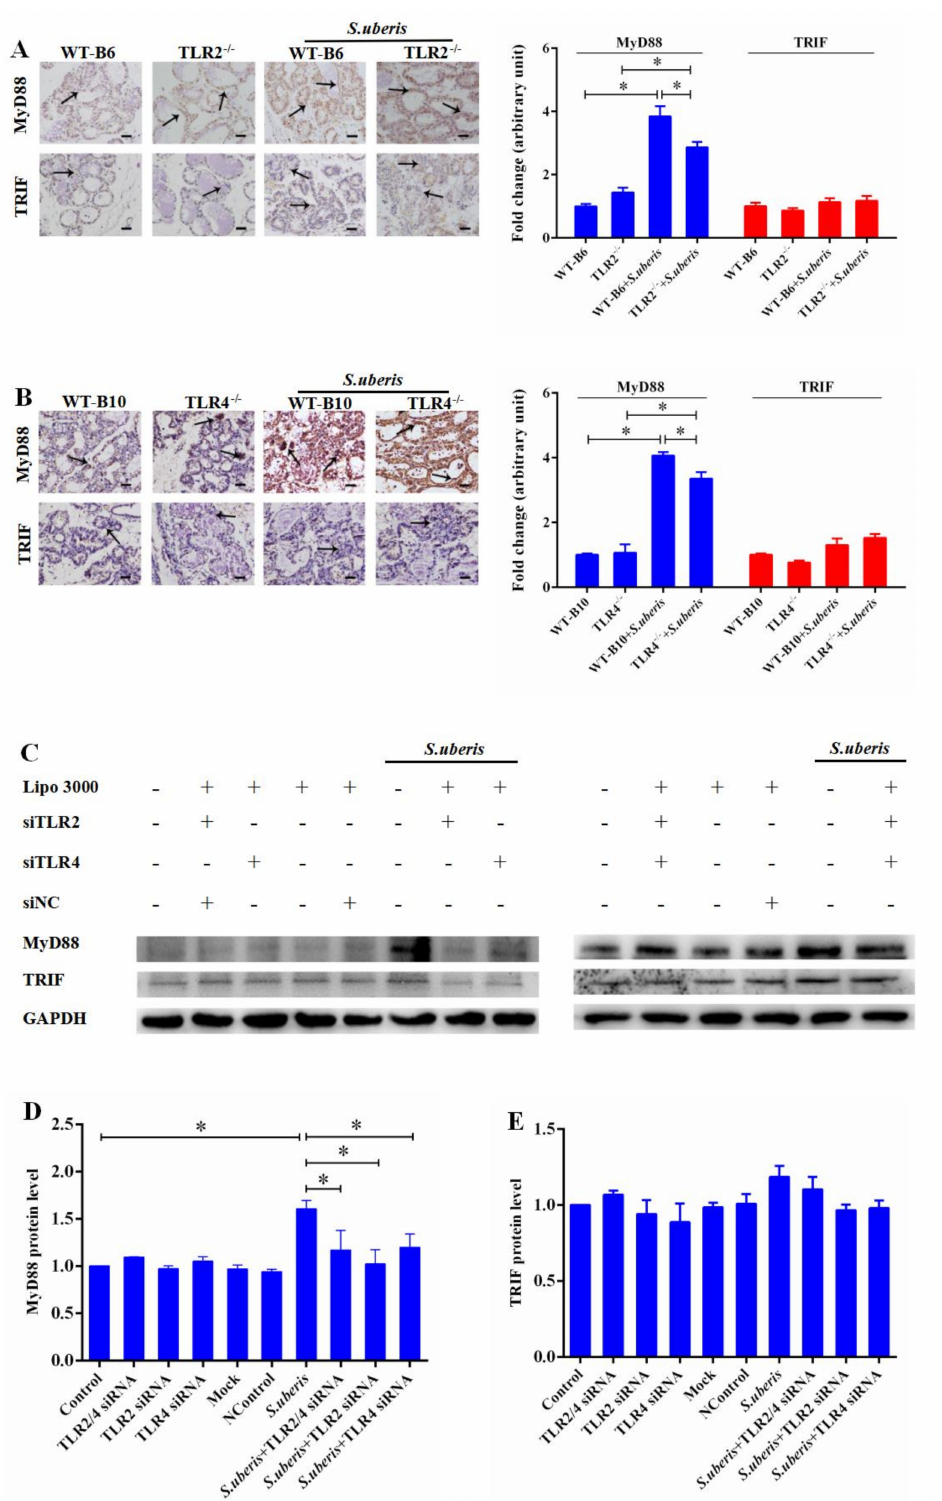
Figure 3. MyD88 dependent pathway predominates in S. uberis infection. ( A ) Immunohistochemistry was used to analyze the protein expression levels of MyD88 and TRIF in mammary gland of WTB6 and TLR2 − / − mice with or without S. uberis . ( B ) Immunohistochemistry was used to analyze the protein expression levels of MyD88 and TRIF in mammary gland of WTB10 and TLR4 − / − mice with or